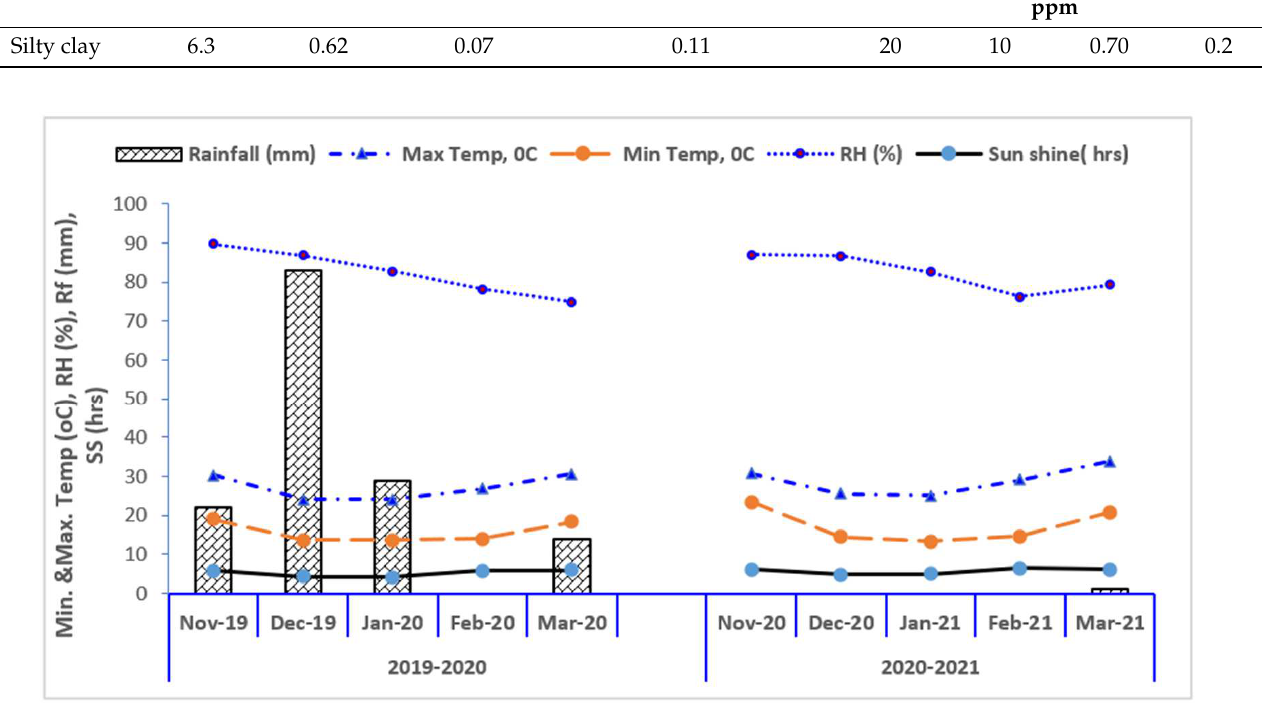
Table 2. List of potato varieties used in the study along with their characteristics.